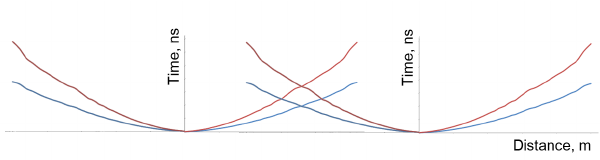
Figure 2. Arrival times at di ff erent distances from EAS axis at the observation level.